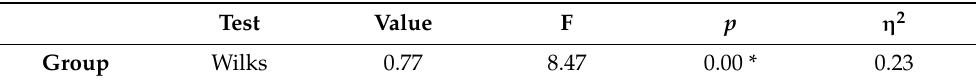
Table 3. Results of MANOVA for repeated measures between the observed groups before and after the fatigue protocol.